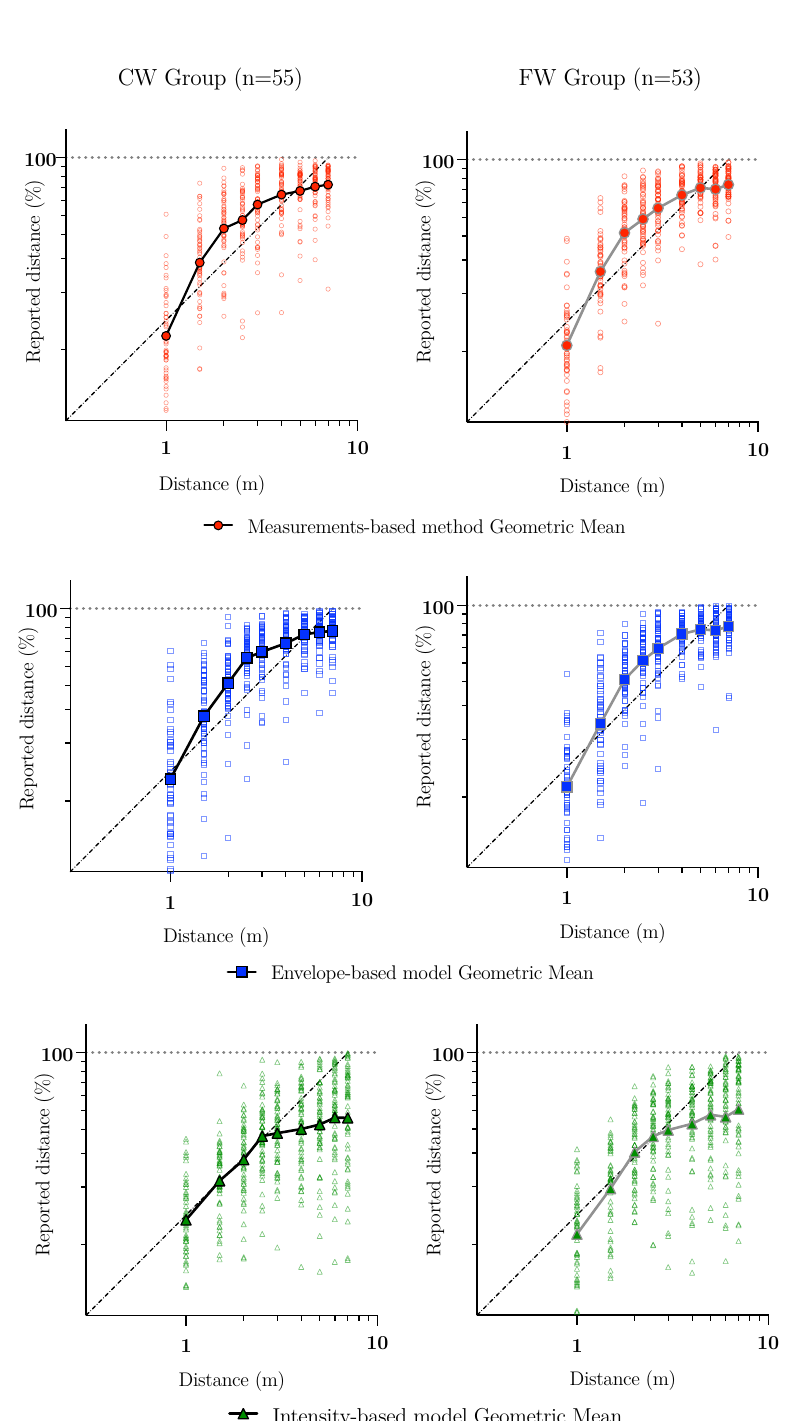
Figure 2. Geometric means of reported distance according to the rendering method used to generate the stimuli and the visual spatial boundary condition. Clear dots represent the geometric mean of a single participant for a given distance, while opaque dots represent the geometric mean over all participants for a given